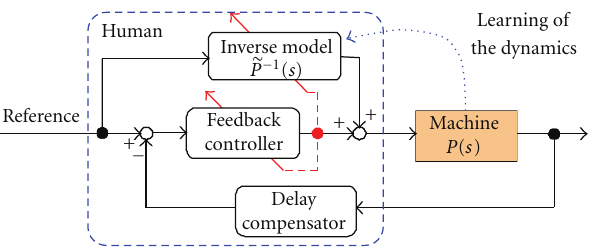
Figure 1: Human model inside a human-machine